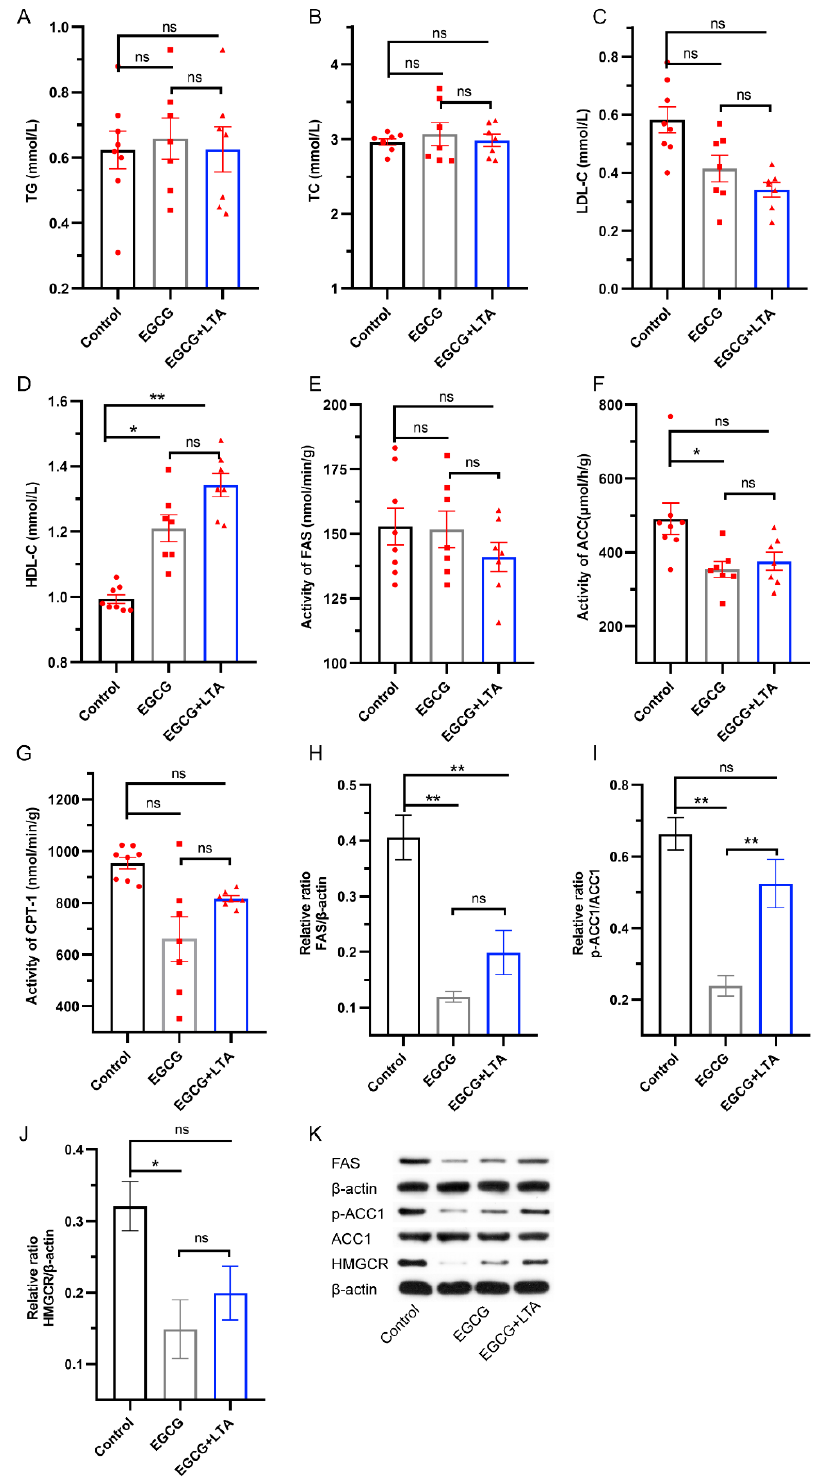
Figure 3. EGCG and LTA co-administration affected lipid synthesis less significantly than EGCG alone. Serum TG ( A ), TC ( B ), LDL-C ( C ), and HDL-C ( D ) contents in different groups. The effects of different treatments on the activities of hepatic FAS ( E ), ACC ( F ), and CPT-1 ( G ). Effects of different treatments on protein expression of FAS ( H ), p-ACC1 ( I ), and HMGCR ( J ) in rat livers ( K ). Values are expressed as the mean ± SE. * p < 0.05 and ** p < 0.01. ns: no significant difference.